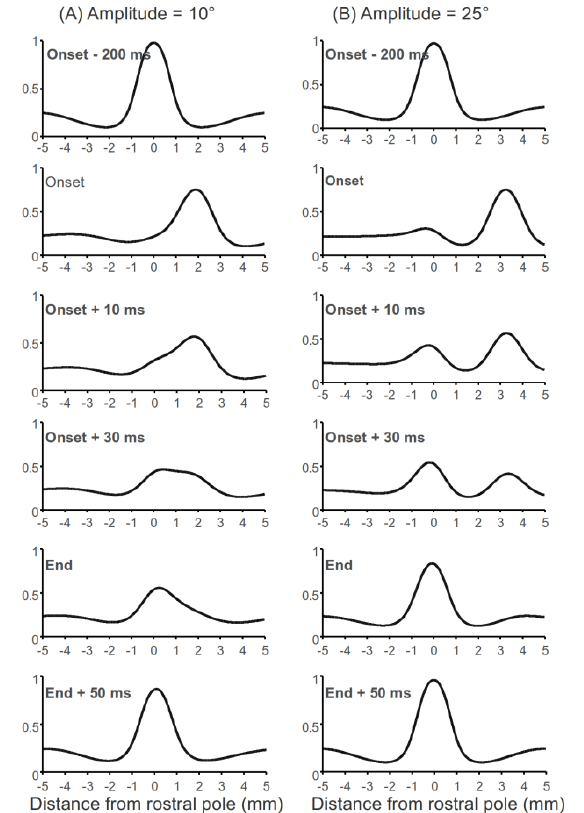
Figure 4 Moving hill and jumping hill during a saccade. In these simulations, input for fixation and buildup neurons were set to d = 10, σ = 0.7 d and d = 12, σ = 0.7, respectively. “Onset” d means the time when a saccade starts and “End” means the time when a saccade